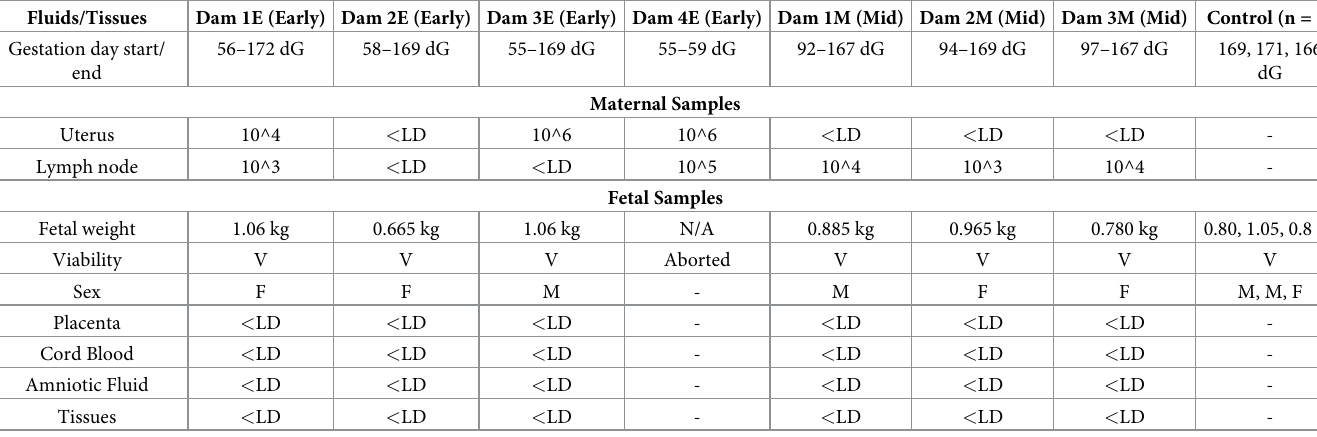
Table 3. ZIKV RNA in select maternal, fetal tissues (copies per mg tissue or per ml of fluid).